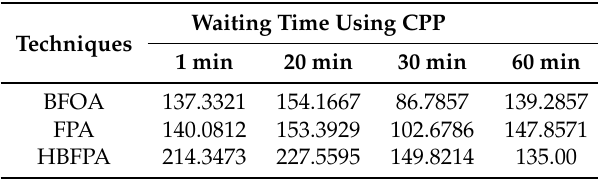
Table 9. Waiting time for 24 h (for single homes).